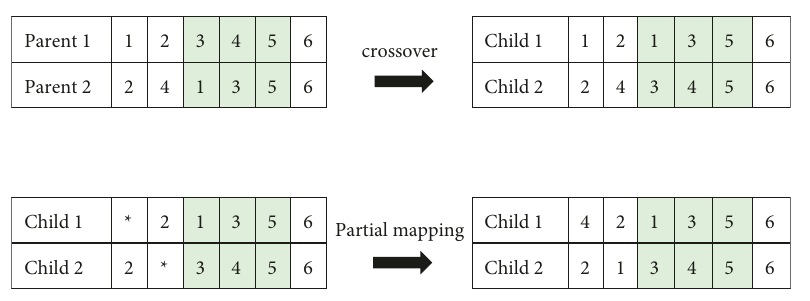
Figure 4: GA Crossover operation.